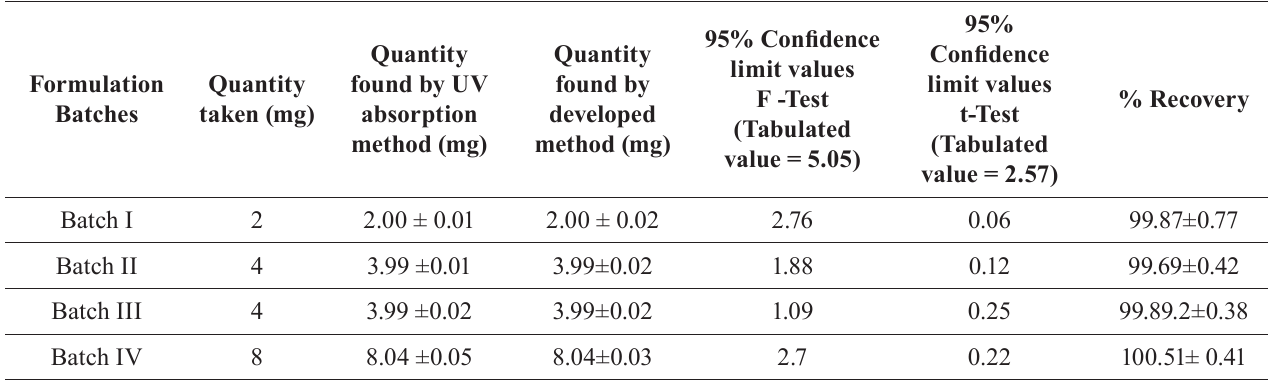
TABLE II - Assay of perindopril erbumine (PPE) in pharmaceutical formulations Proposed scheme for the formation of coloured species